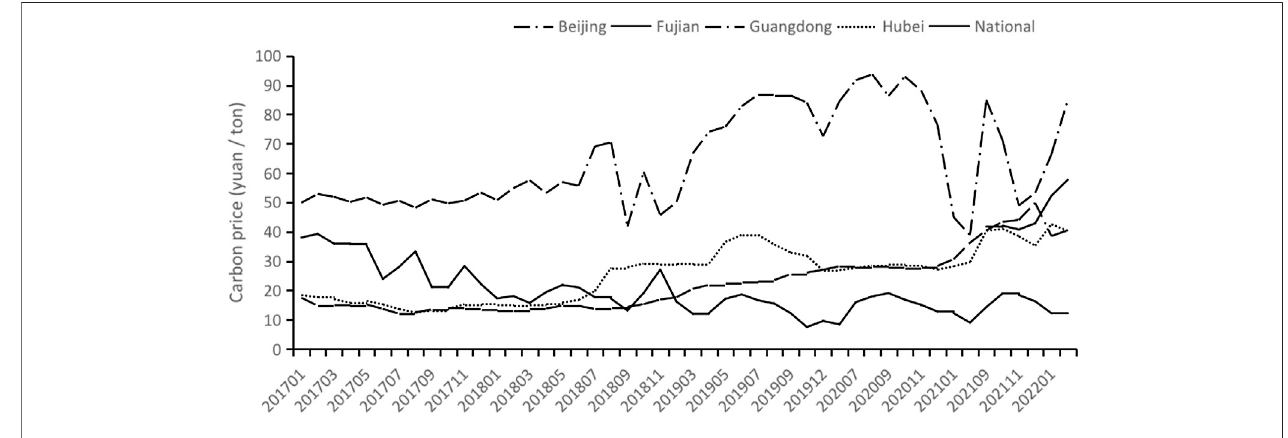
FIGURE 1 | Average monthly carbon price in